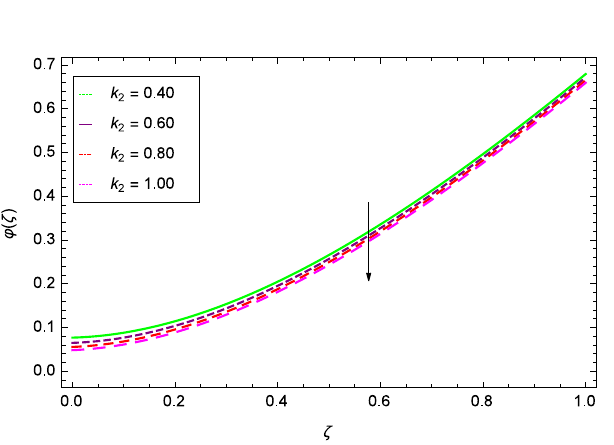
Figure 34. Parameter effect on concentration of homogeneous chemical reactions ϕ ( ζ ) profile.